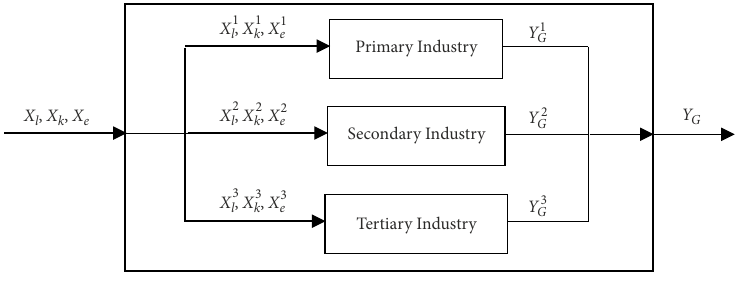
Figure 1. Economic structure in China (adapted from Bian et al., 2016)